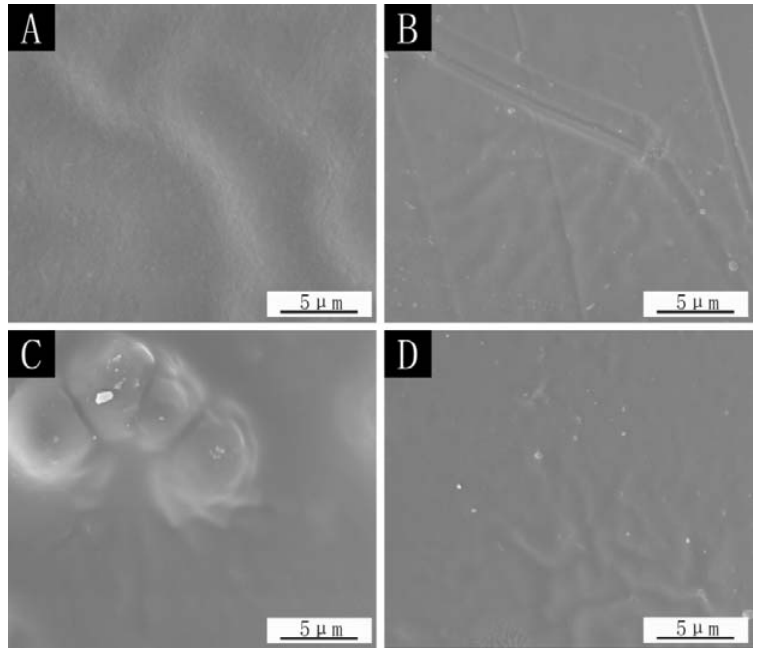
Figure 6. SEM images of the paint film surface in different addition methods: ( A ) the paint film without microcapsules, ( B ) microcapsules in primer, ( C ) microcapsules in topcoat, ( D ) microcapsules in primer and topcoat added at the same time.